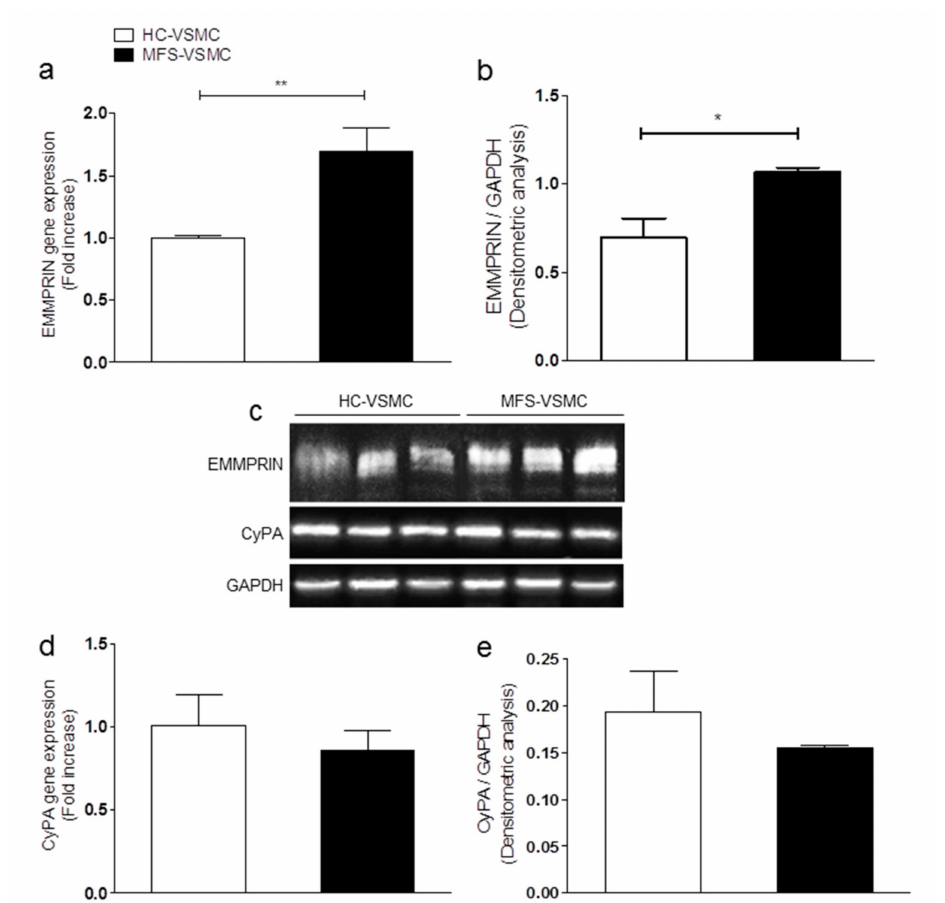
Figure 3. EMMPRIN expression levels are higher in vascular smooth muscle cells (VSMC) isolated from the thoracic aorta of MFS patients. ( a , d ) EMMPRIN ( a ) and CyPA ( d ) gene expression in RNA extracts of HC-VSMC (white bars) and MFS-VSMC (black bars). qRT-PCR analyses have been performed in triplicate and data are shown as fold change ± SD, n = 5. Student’s t -test: * p < 0.05, ** p < 0.01. ( c ) Western Blot of EMMPRIN and CyPA proteins in total extracts of HC-VSMC and MFS-VSMC, n = 3. ( b , e ) Quantification of EMMPRIN ( B ) and CyPA ( e ) Western blot. Data are shown as mean ± SD, n = 3. Student’s t -test: * p <